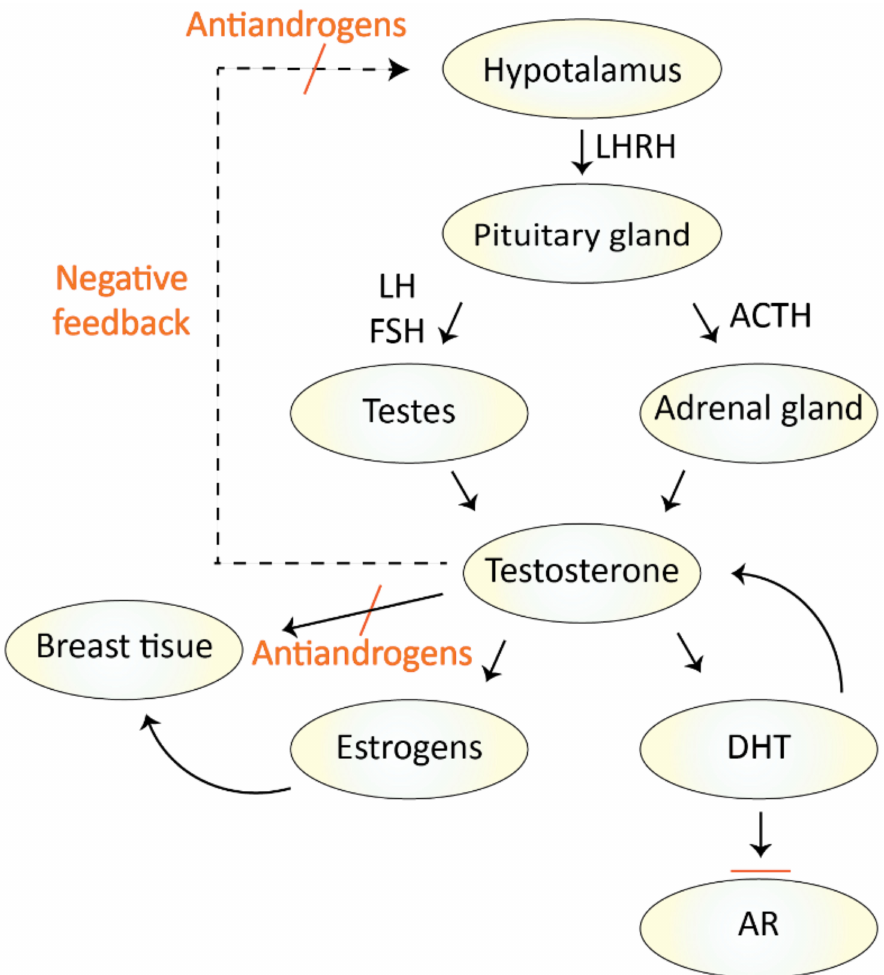
Figure 2. The mechanism of action of nonsteroidal antiandrogens in endocrinologic pathways in men; adapted and adjusted from ref. [6]. LH—luteinizing hormone; LHRH—luteinizing hormone-releasing hormone; FSH—follicle-stimulating hormone; ACTH—adrenocorticotropic hormone; AR—androgen receptor;